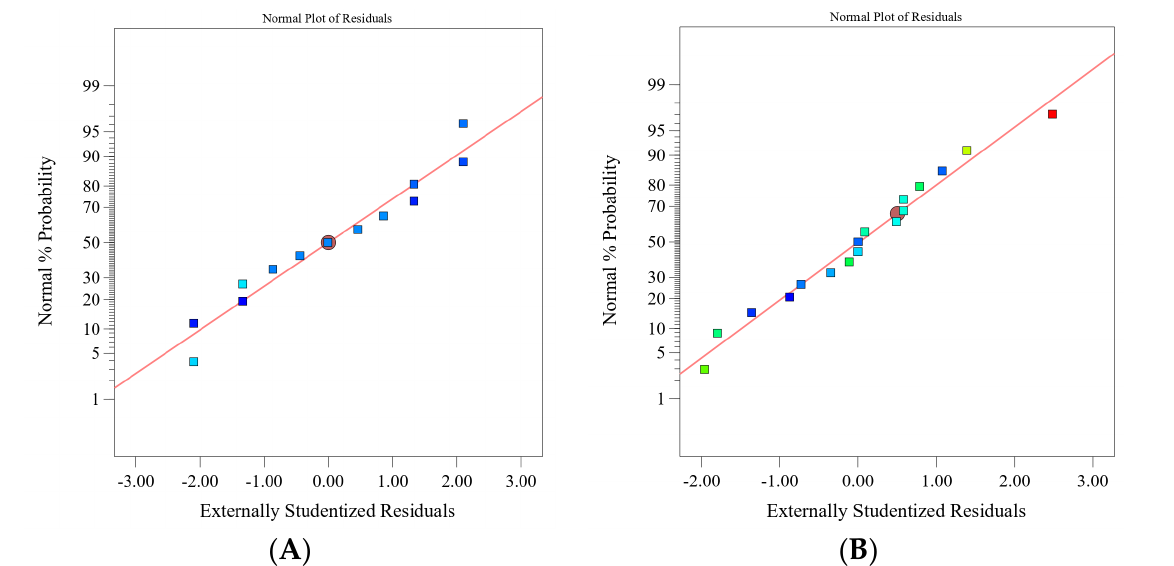
Figure 5. Normal plot of residuals: ( A ) amounts of aluminium ions, and ( B ) density. The model of density has an acceptable shape for the residuals as a function of the predicted values (Figure 5B) and signal-to-noise ratio (6.7 > 4). The R 2 value of 80% may be considered high enough for obtaining a precise prediction of the density value with the obtained